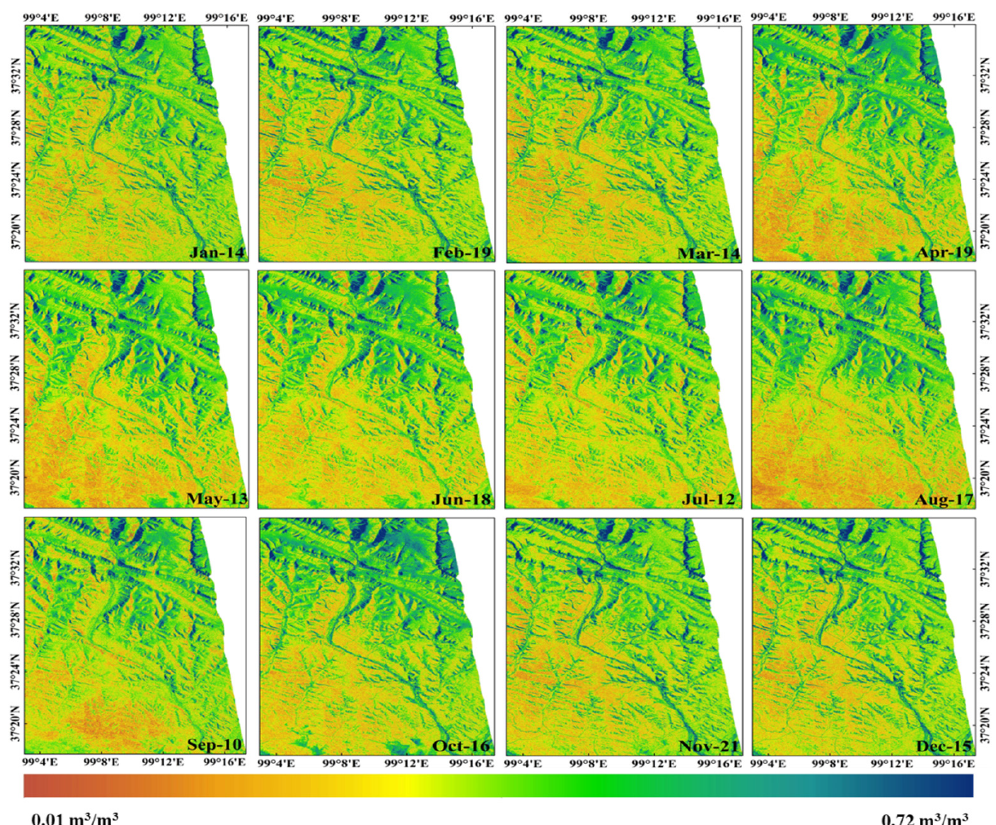
Figure 11. Soil moisture with RF for descending orbit of Maqu network for 2018.